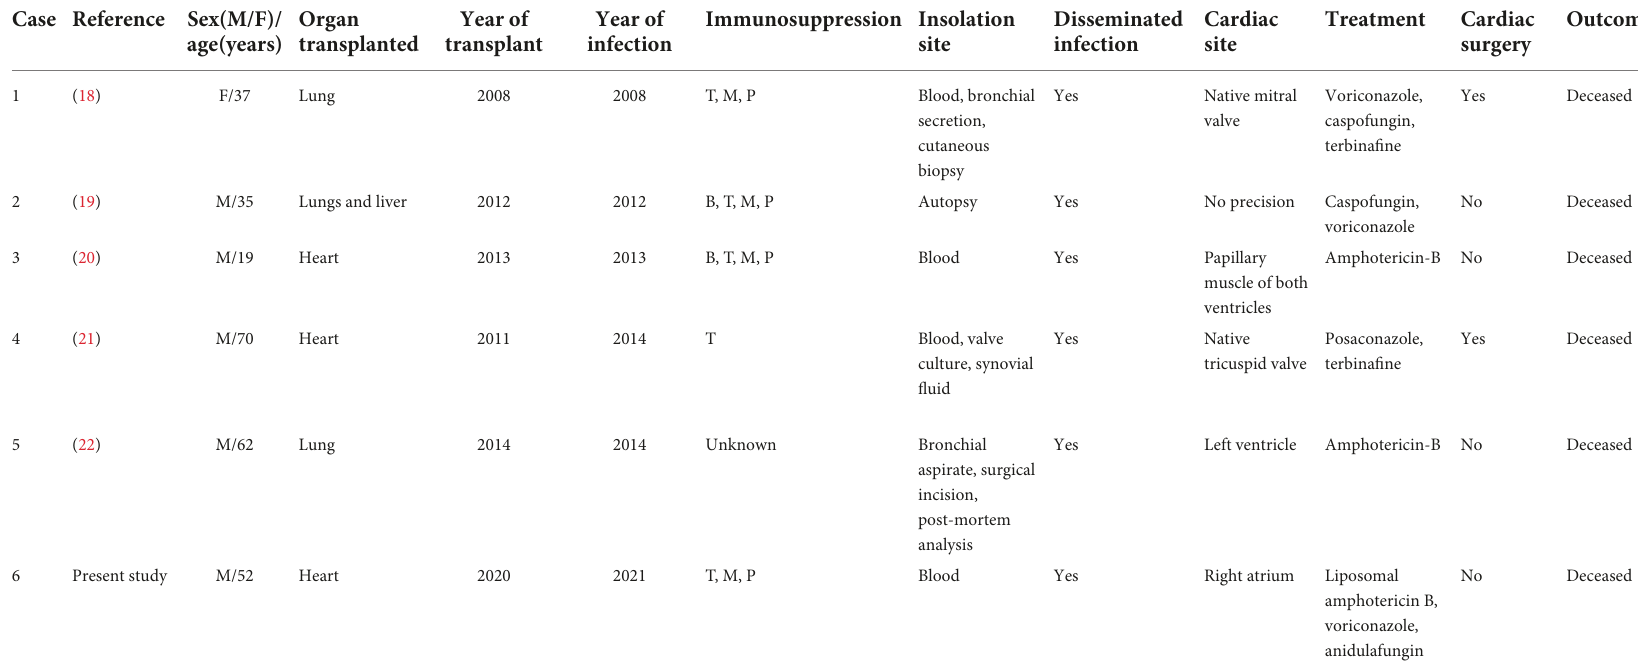
TABLE 1 Literature review of infective endocarditis caused by Scedosporium spp. in solid transplant patients. Case Reference Sex(M/F)/ Organ age(years)